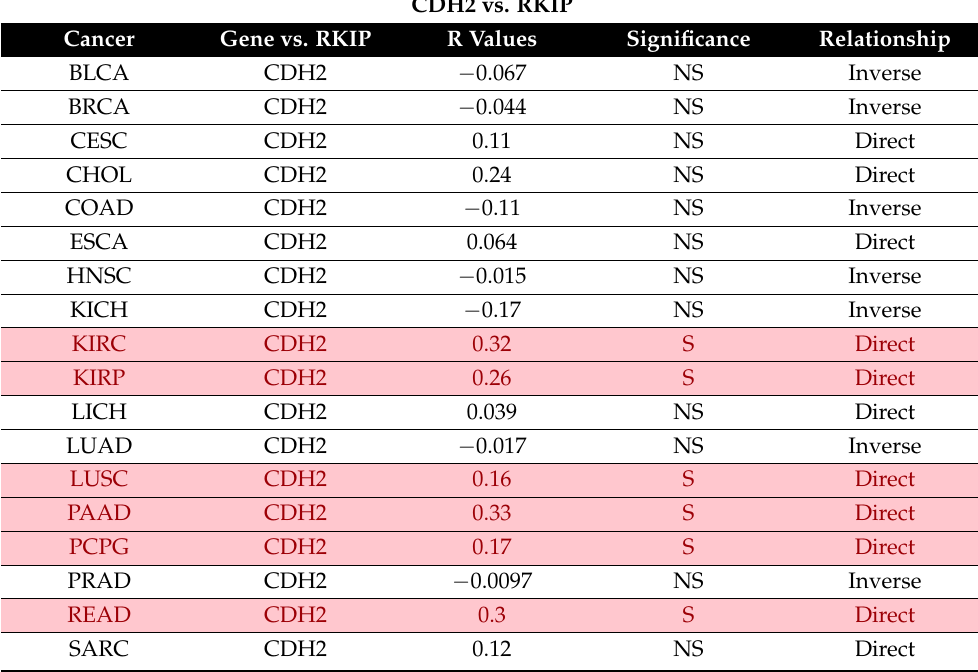
Blue: Significant Inverse Relationship; Red: Significant Direct Relationship. Table 3. RKIP vs. CDH2. A bioinformatic analysis was performed across 23 different cancer types comparing the presence of RKIP against CDH2. From this data, a p -value and an R value were determined for each of the cancer types. The table above organized the bioinformatic data. For each cancer type, the R value was reported in the third column. Significance was determined based on the p -value, with a p -value less than 0.05 indicating a significant value. The relationship between RKIP and CDH2 was determined through the sign of the R value. A negative R value indicated an inverse relationship while a positive R value indicated a direct relationship. The rows highlighted in blue indicate a significant, inverse relationship between RKIP and CDH2. The rows highlighted in red indicate a significant, direct relationship between RKIP and